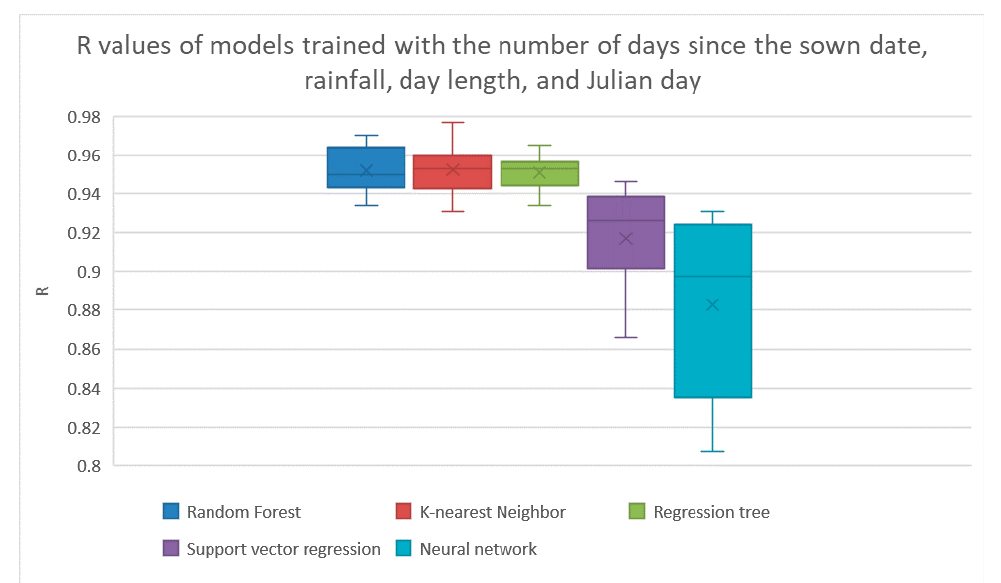
Table 8. The best R value of these methods was also k-nearest neighbors getting an average R of 0.952.